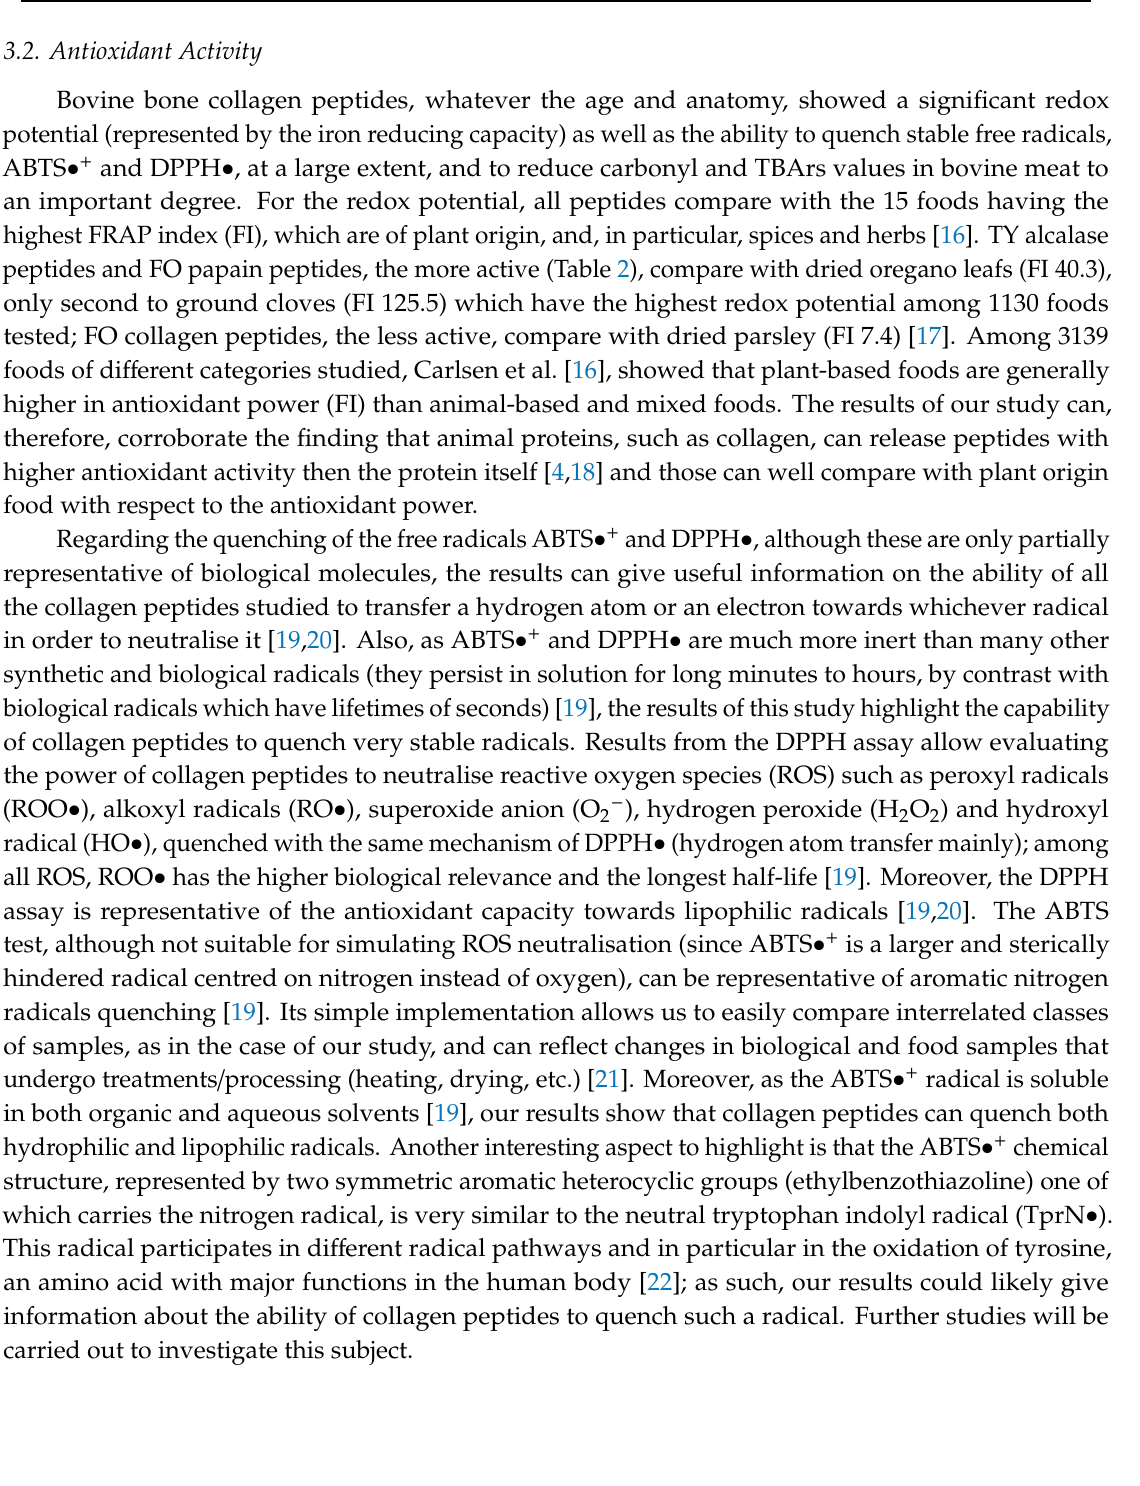
Table 9. Molecular weight, specificity, cutting sites, and optimal pH and temperature of hydrolysis for the 6 enzymes (endopeptidases) tested to hydrolyse bovine bone collagen (AA = amino acid). MW Specificity / Cutting Sites Temperature ( ◦ C) pH Enzyme (kDa) Alcalase 20–45 non-specific / larger and uncharged AA Collagenase B 68–130 specific / Gly-AA 37 Esperase 20–30 non-specific / larger and uncharged AA